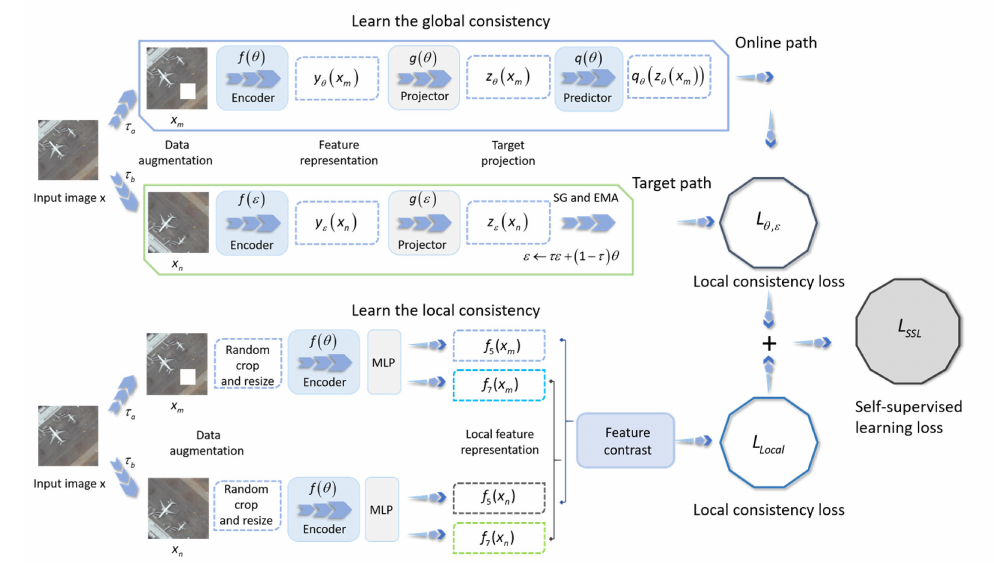
Figure 2. Schematic diagram of self-supervised learning we use. This process consists of two dual- path modules. The first module uses BYOL to learn global consistency, which contains two paths: the online path and the target path. The model is trained by minimizing the global consistency loss between the online path and the target path containing SG and EMA. The θ is the weight of the model. SG is the stop gradient. EMA is the exponential moving average, and ε is the exponential moving average with respect to θ whose decay rate is τ . The second module uses feature contrast learning to learn local consistency, which is divided into two paths. The core of this module is to minimize the loss of local consistency between the local feature representations extracted by the encoder in different views of the same remote sensing image. There are many options for data augmentation